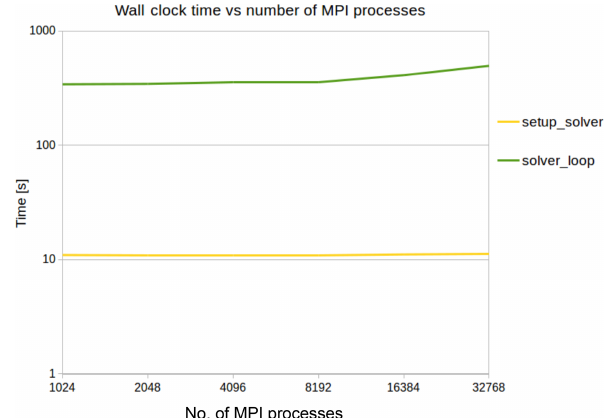
Figure 6. Execution time versus the number of MPI processes for the regions of interest, running the weak scaling experiment up to 32768 MPI